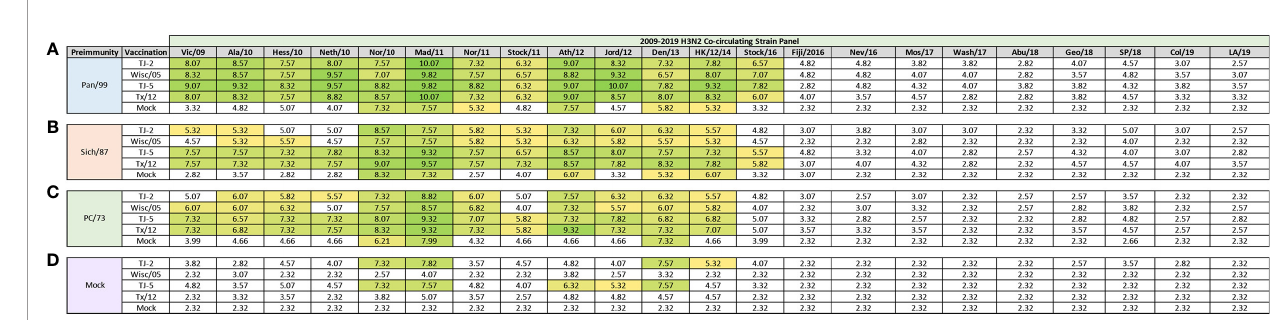
FIGURE 6 | Day 98 H3N2 Co-Circulating Strain HAI Panel. Serum collected from animals 98 days post infection (14 days after fi rst vaccination) was analyzed for HAI activity against a panel of co-circulating H3N2 in fl uenza strains spanning 2009-2019. Table is divided into sections based on the virus each animal received to establish preimmunity: A/Panama/2007/1999 (A) , A/Sichuan/2/1987 (B) , A/Port Chalmers/1/1973 (C) , or PBS (Mock) (D) . Cells in table are color coded as a heat map based upon Log(2) HAI geometric mean titer (GMT) for each group of ferrets (N=4). The heat map colors cells yellow at Log(2) GMT of 5.32 which correspond to an HAI titer of 1:40 and cells become a darker shade of green as the average antibody titer of the group increases. Cells with no color correspond to groups that did not achieve a GMT